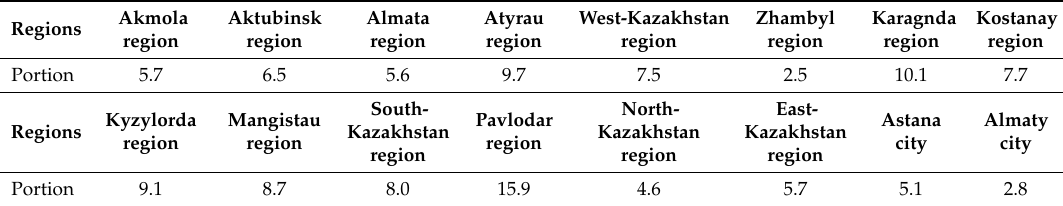
Table 3. The share of electricity costs in the total cost structure (%).